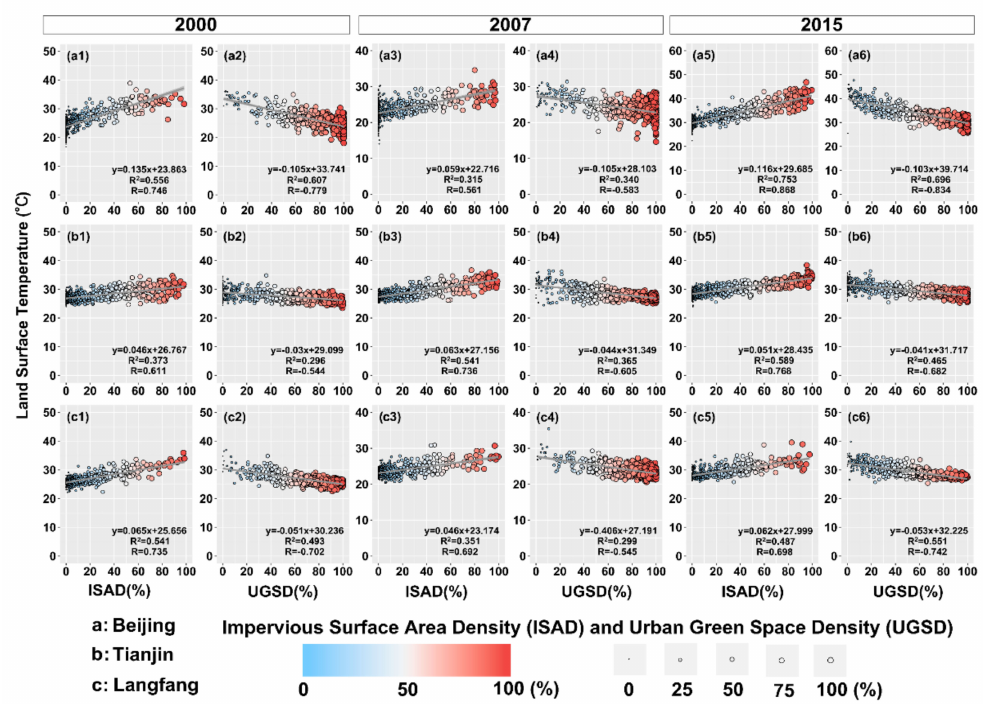
Figure 7. The relationship between the ISAD, UGSD and the LST across Beijing, Tianjin and Langfang from 2000 to 2015. Different colors and the size of bubbles denote the magnitude of the ISAD and UGSD.